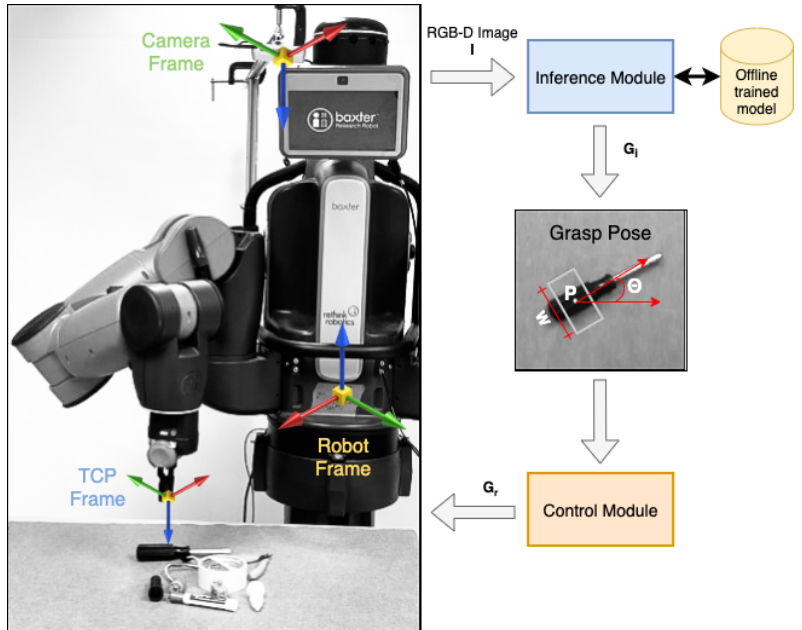
Figure 1. Overview. A real-time multi-grasp detection framework to predict, plan and perform robust antipodal grasps for the objects in the camera’s field of view using an offline trained GR-ConvNet model. Our system can grasp novel objects in isolation as well as in clutter. Video (accessed on 20 July 2022):